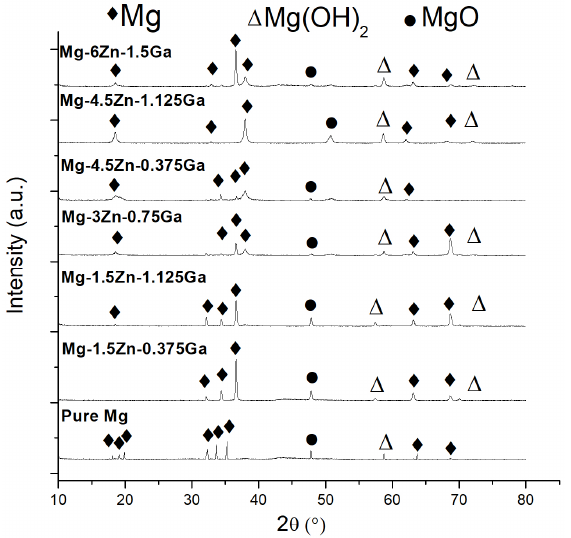
Figure 5. XRD patterns of the as-cast Mg-Ga-Zn alloys after 168 h of immersion in SBF.